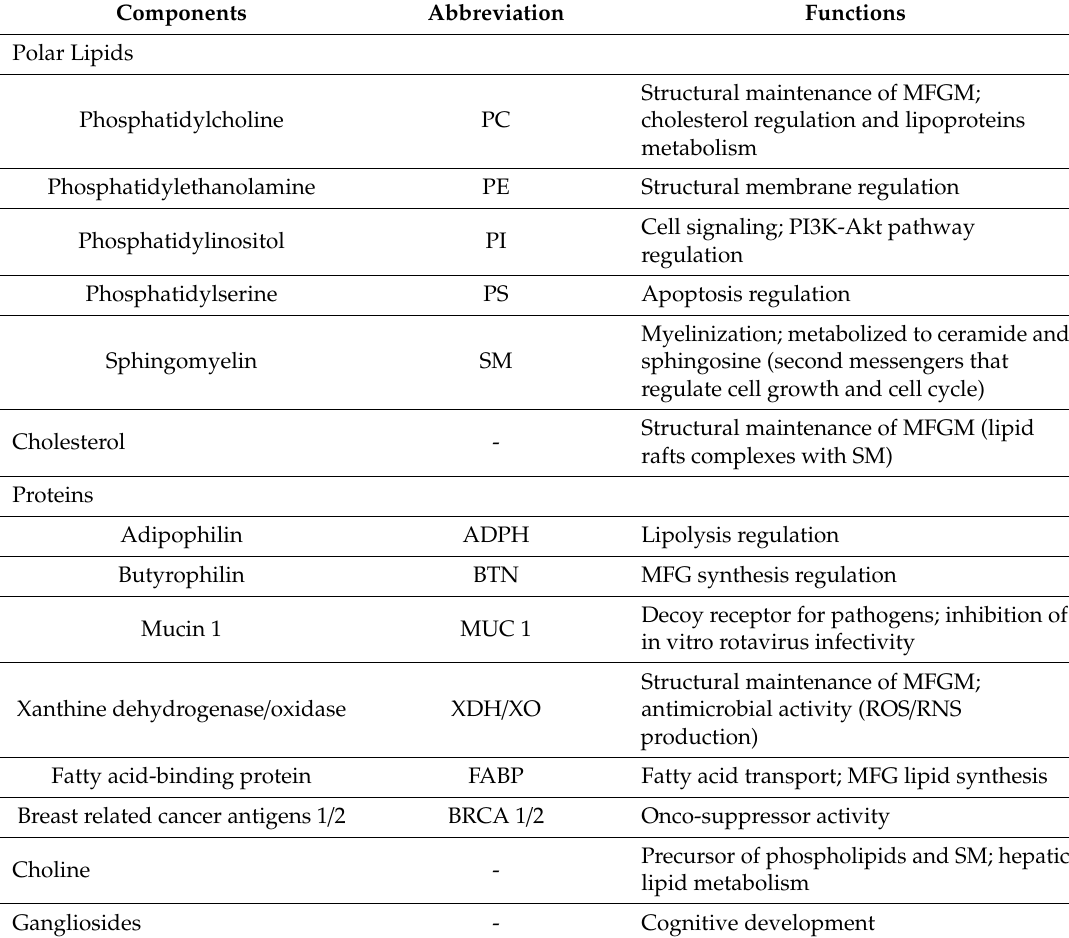
Table 2. Functions of the main components of bovine MFGM. Data from Lee et al., 2018